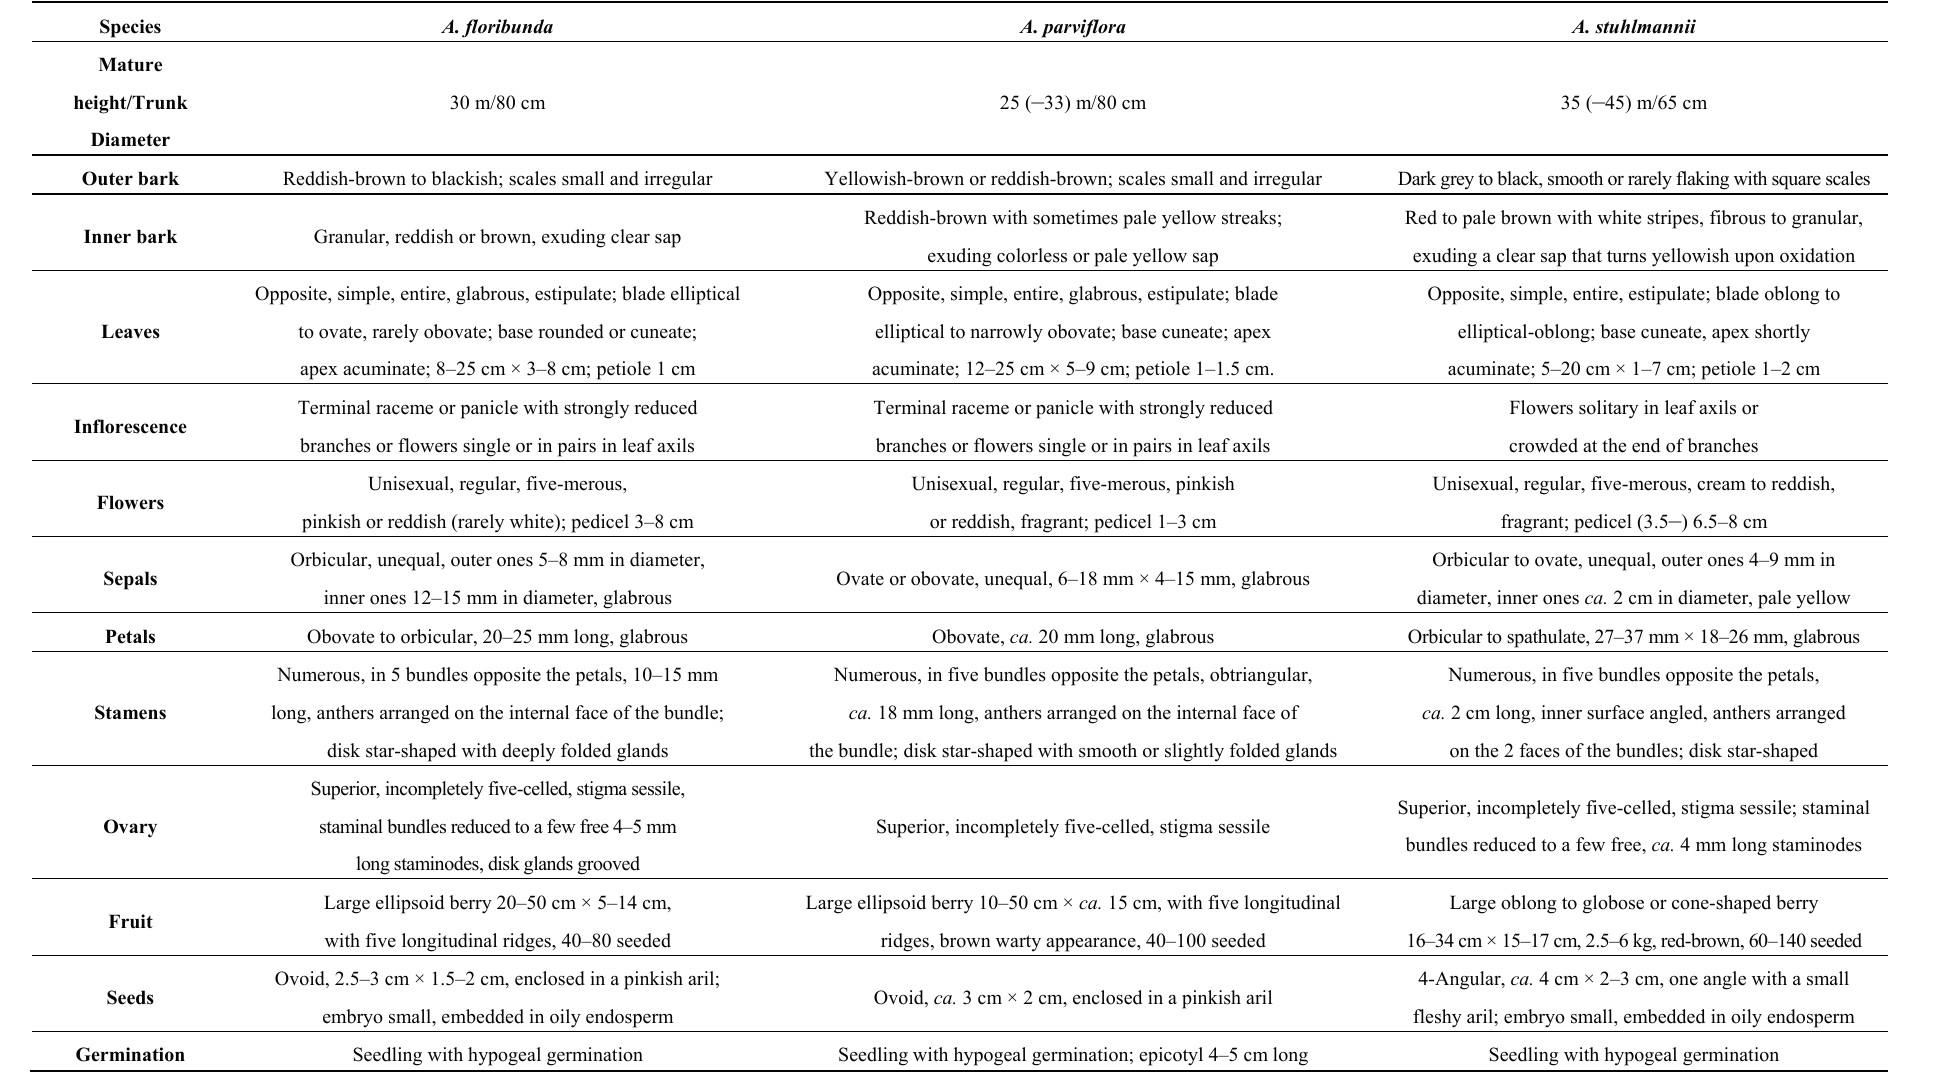
Table 1. Botanical characteristics of three species of Allanblackia of commercial interest